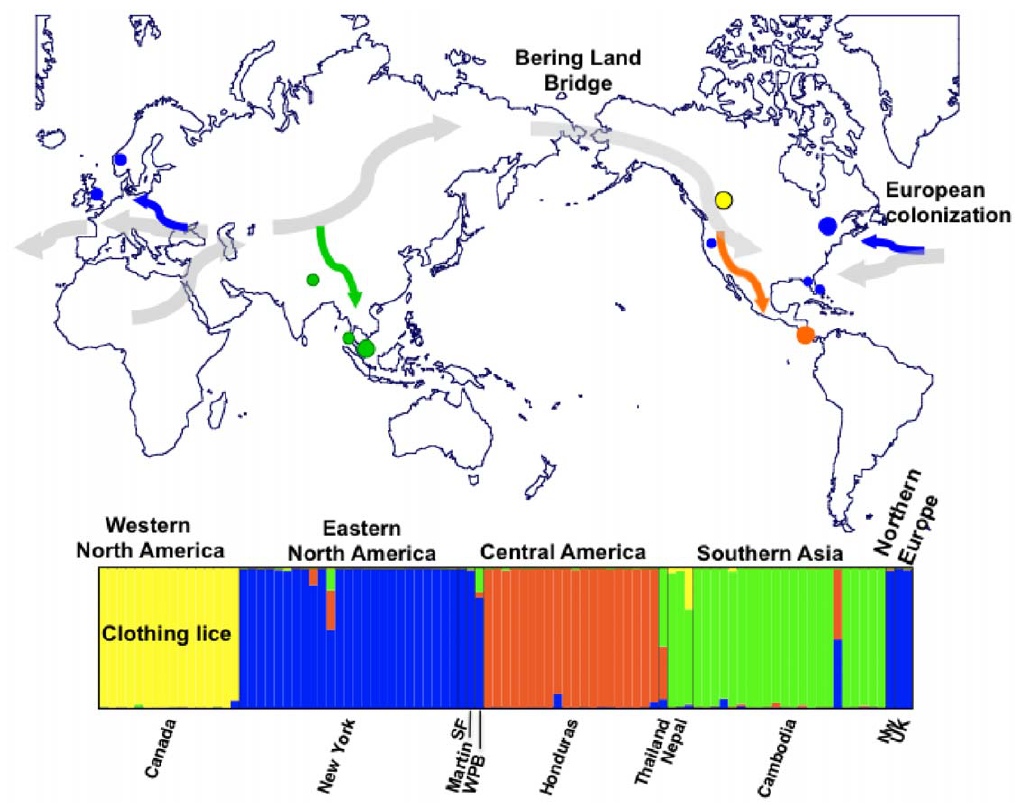
Figure 6. Map depicting the geographic distribution of the nuclear genetic diversity among the human louse populations included in this study. Colored circles on map indicate collecting sites, with the color of each circle corresponding to the majority nuclear genetic cluster to which sampled individuals were assigned. Large colored circles are sites with 16 or more lice, small colored circles represent sites with one to three lice. Thick grey arrows indicate proposed migrations of anatomically modern humans out of Africa into Europe, Asia and the Americas, as well as the more recent European colonization of the New World. Colored arrows represent hypothetical human louse co-migrations. The bottom panel is the plot from STRUCTURE corresponding to the assignment of 93 lice from 11 geographical sites (from Figure 4A). Figure S1 Microsatellite abundance (counts): Data are shown for di- (diagonal lines), tri- (grey), and tetra- (solid black) per number of repeat motifs. Figure S2 Average pairwise relatedness ( r ) of lice within sites. Relatedness values can range from 1 (individuals are identical for all alleles assessed) to –1 (individuals have no alleles in common).